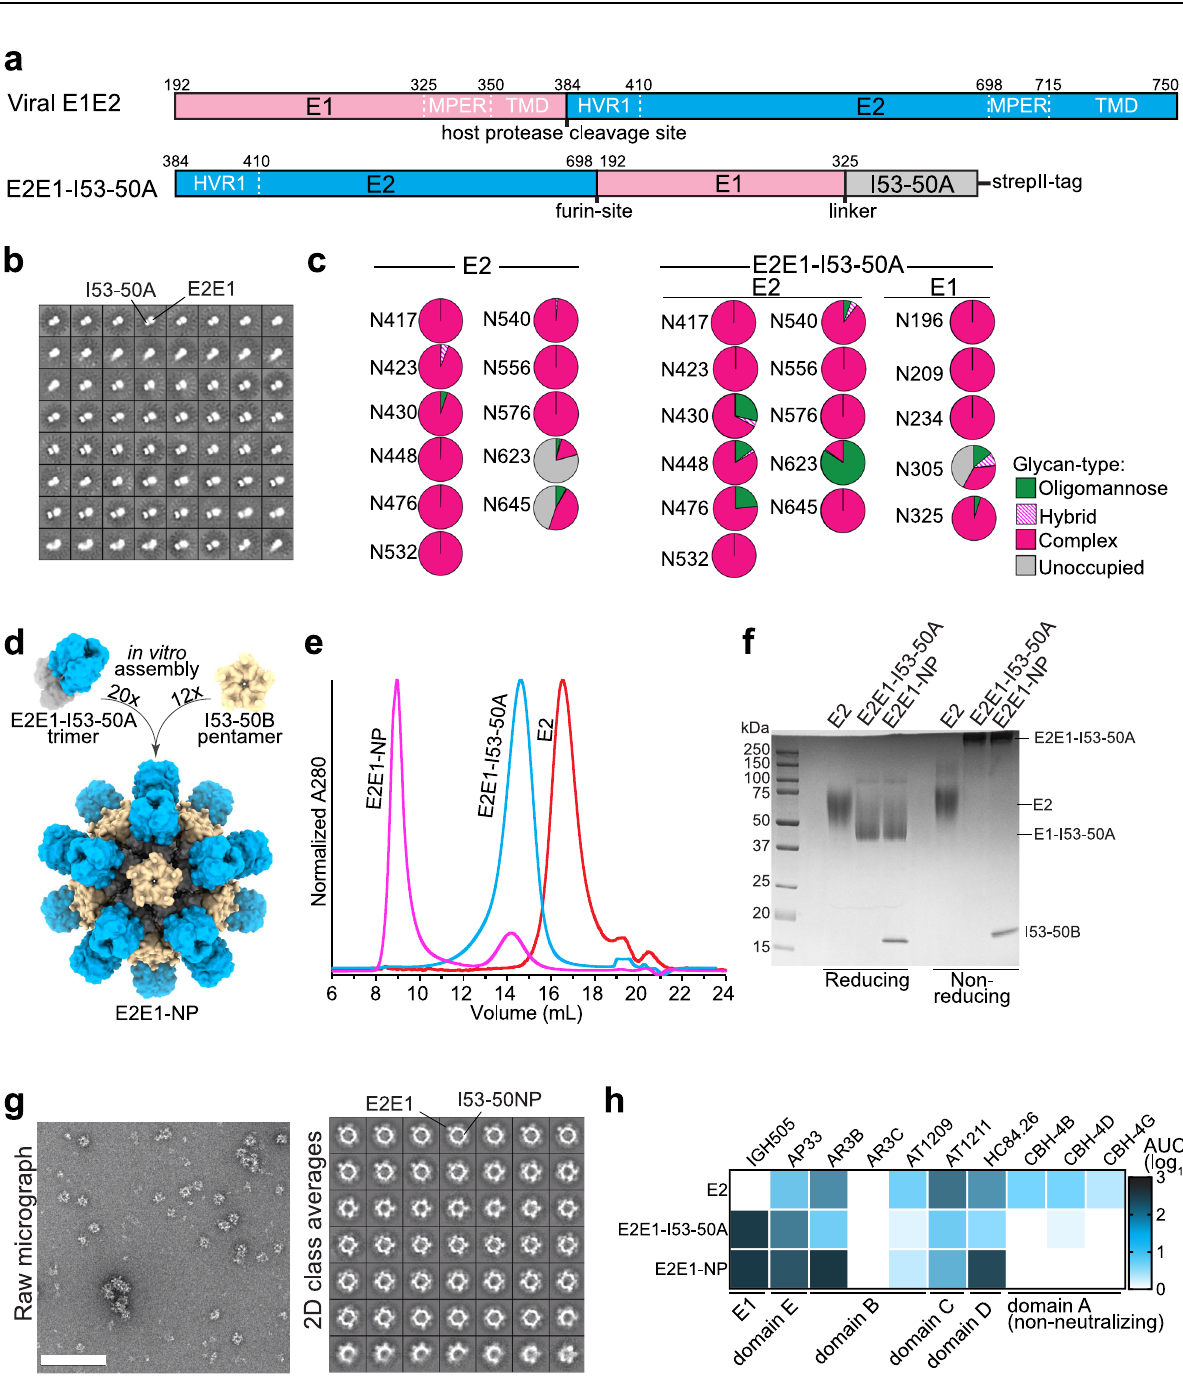
magenta), and oligomannose glycans (green). d Schematic representation of the in vitro assembly of E2E1-I53-50 nanoparticles (E2E1-NP) by mixing E2E1-I53-50A trimersandthepentamericI53-50Bsubunits. e SECpro fi lesofE2E1-I53-50Atrimers before assembly (blue) and post-assembly (magenta) in a Superose 6 column. E2 monomeris shownforcomparison (red). f Reducing andnon-reducingSDSgelsof E2, E2E1-I53-50A, and E2E1-NP. Representative example of two experiments. g NS- EMimagesofE2E1-NPswithanexamplerawNS-EMimageleftand2Dclassaverages right. The white scale bar represents 200nm. h Binding signal data derived from BLI (example curves depicted in Fig. S4a). Monoclonal antibodies (mAbs) were loaded on protein A sensors and binding signal was measured using an equimolar amount of E2 (100nM). Depicted are the logarithms of the mean area under the curve (AUC) values from two independent experiments. Source data are provided as a Source data fi le.